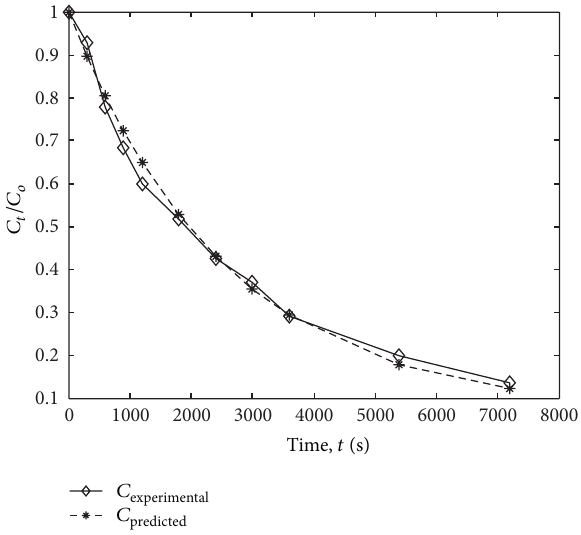
Figure 19: Variation of dimensionless bulk concentration of MB with time for initial bulk concentration of 150 mg/L.